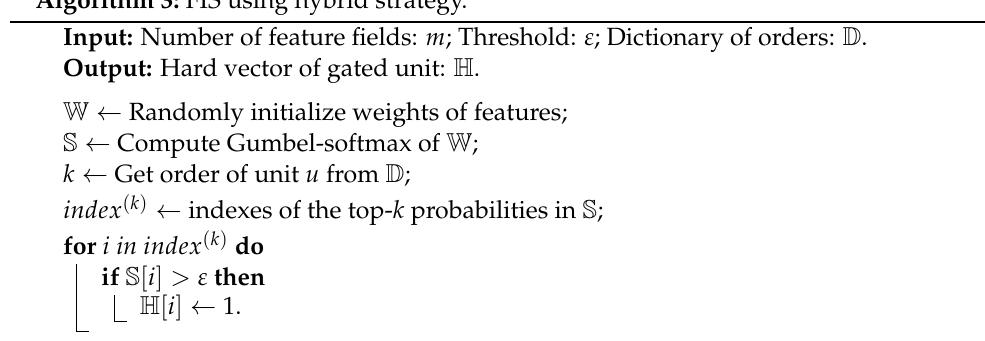
Algorithm 3: FIS using hybrid